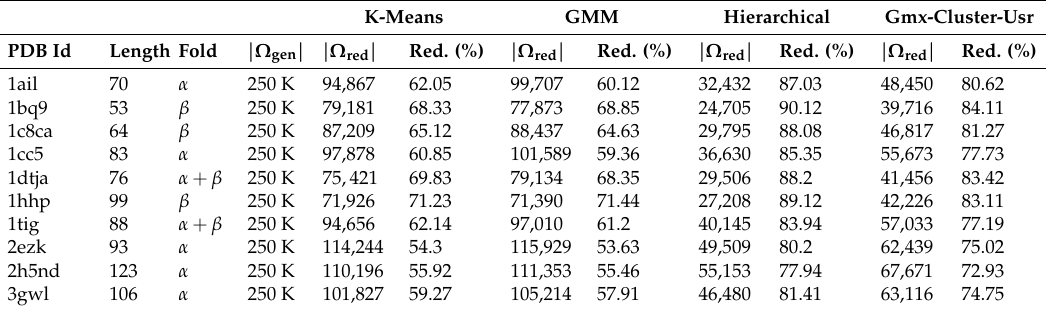
Table 1. Ω gen and Ω red are compared in terms of size over the benchmark dataset. The PDB ids, lengths, and folds of the dataset are shown in Columns 1–3. Column 4 shows the size of Ω gen . The size of Ω red and the reduction of Ω red over Ω gen are shown in Columns 5–12 for all clustering algorithms.